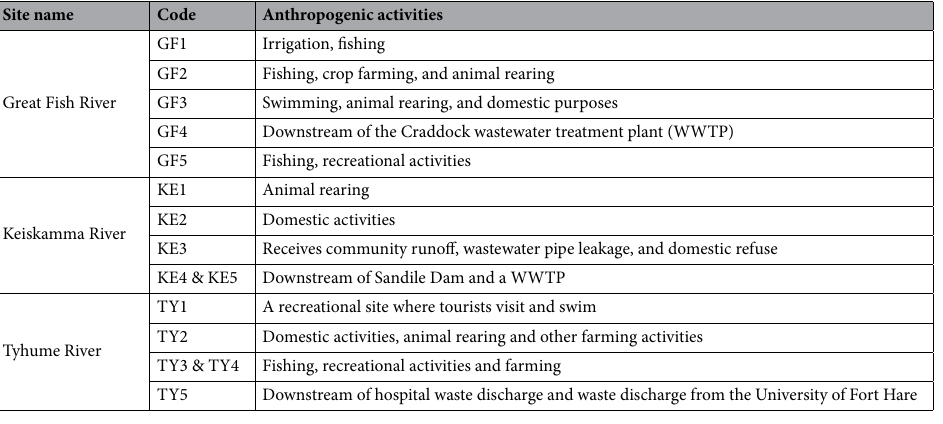
Table 1. Anthropogenic activities of the sampling